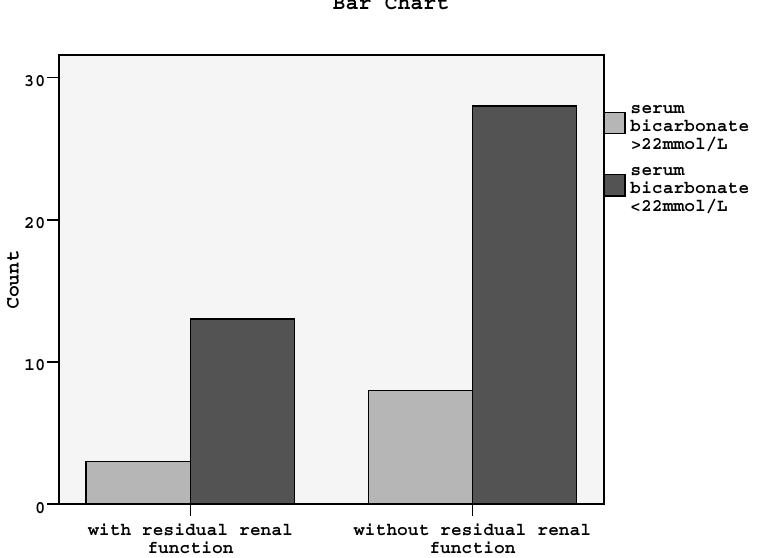
Figure 4. Bar chart for the association between residual renal function and metabolic acidosis status (log-rank = 3.9, p = 0.04).